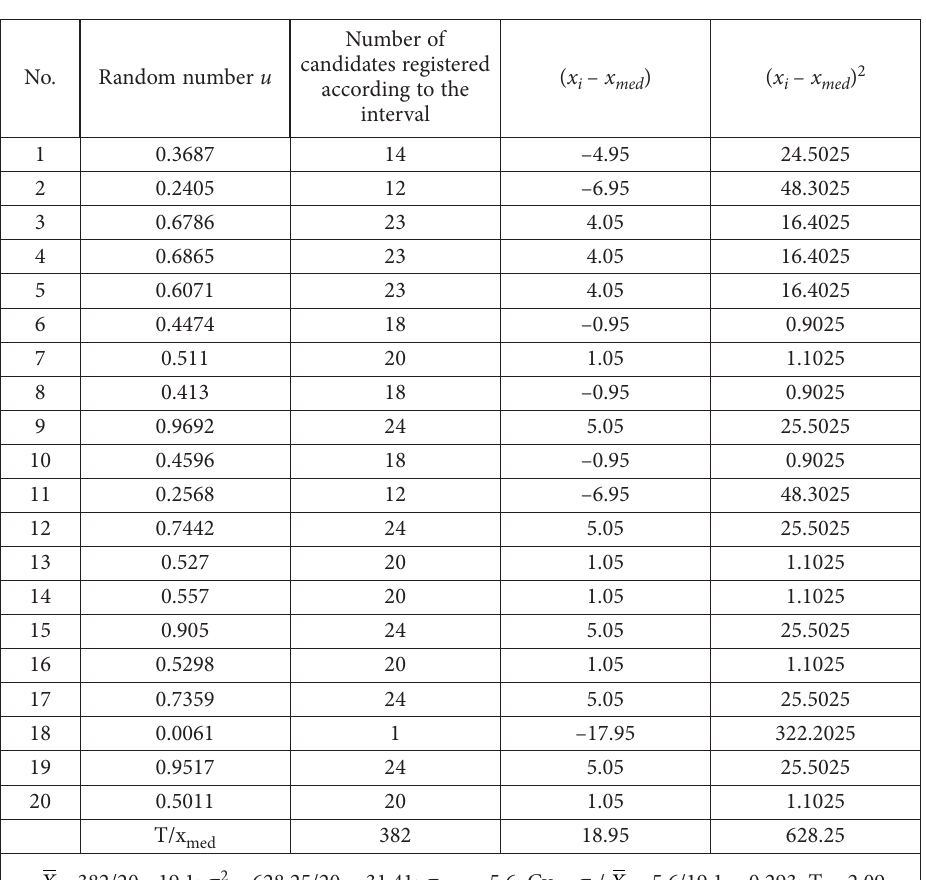
Figure 1. Generating a value xi of discrete probabilistic variable Table 5. Generating random number